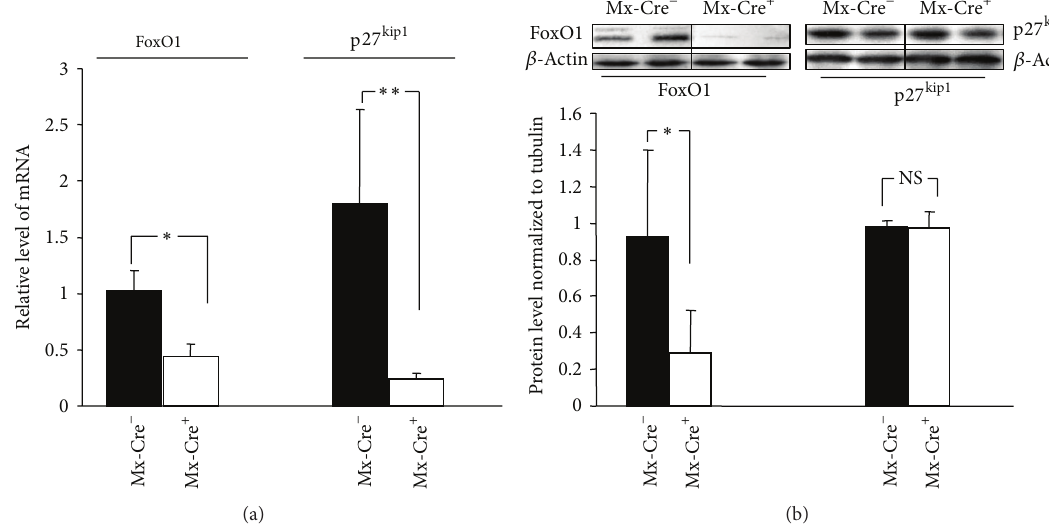
Figure 3: Functional studies checking the relationship between FoxO1 and p27 kip1 in liver tissue. (a) Pharmacologically induced inactivation of FoxO1 results in suppression of FoxO1 and p27 kip1 gene expression in the experimental Mx-Cre + FoxO1/3/4 mice in comparison to control Mx-Cre − FoxO1/3/4 mice. (b) FoxO1 protein expression is strongly reduced. Somatic deletion of FoxO1 gene did not affect the p27 kip1 protein level. Results are representative of 5-6 independent experiments. Changes in protein levels were determined by densitometry analyses after normalization to 𝛽 -actin as a control for loading. Bars indicate the mean ± SEM ( ∗ 𝑃 < 0.05 ; ∗∗ 𝑃 < 0.01 versus control).